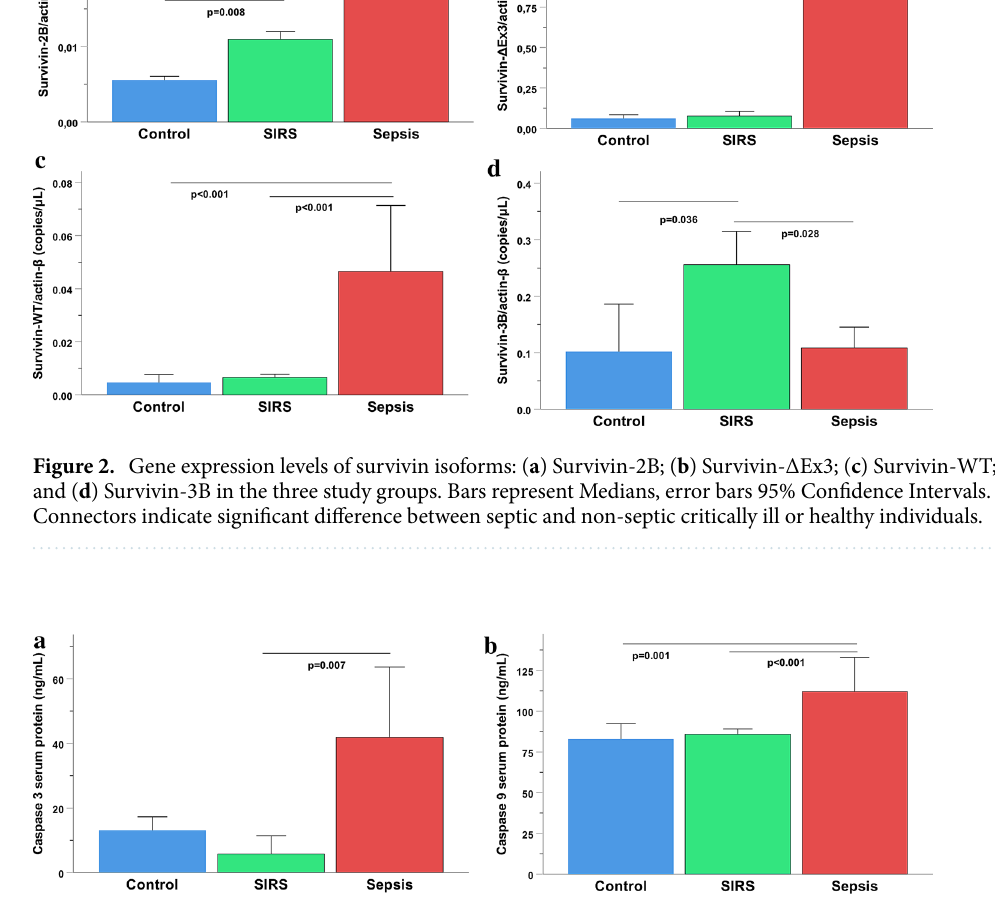
Figure 3. Serum levels of total caspases enzymatic concentrations, including pro-caspases, the cleaved subunits, and the active heterodimers: ( a ) Caspase-3 and ( b ) Caspase-9 in septic patients compared to SIRS and healthy controls. Bars represent Medians, error bars 95% Confidence Intervals. Connectors indicate statistical significant difference between septic and non-septic critically ill or healthy